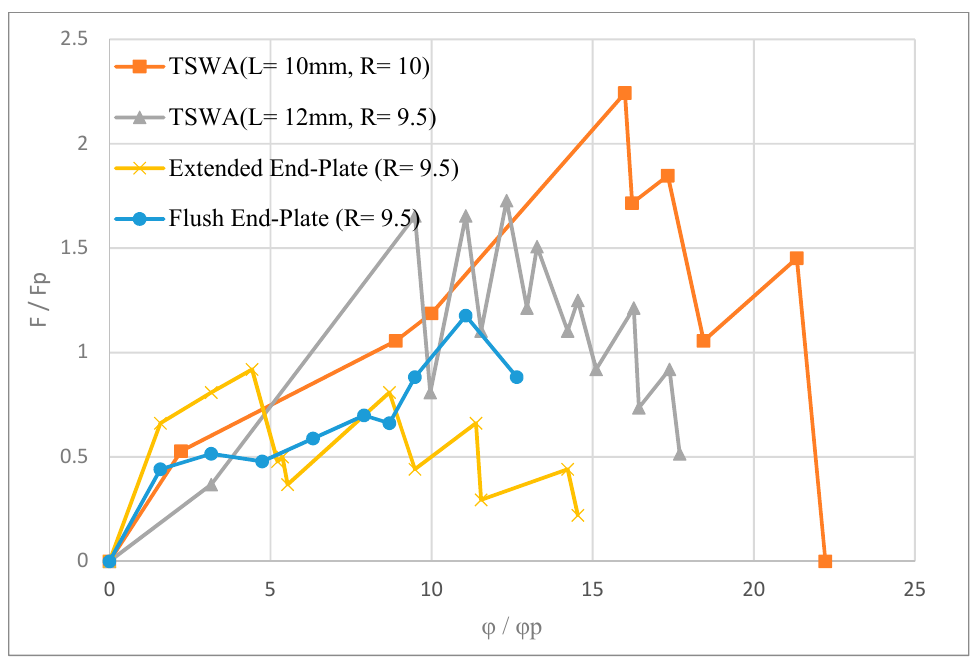
Figure 5. Normalized pushdown resistance against normalized rotation of semi-rigid connections. The normalized force versus normalized rotation for all tested fully rigid connections is shown in Figure 6. This category possesses the highest stiffness, where in the normalized rotation of around 2, almost all specimens develop the full plastic moment of connected beams. In addition, Figure 6 shows that by considering unique configuration and large R i , SidePlate has the highest stiffness and ultimate strength. Generally, the previous literature indicated that ductility demand for traditional rigid connections in the case of column removal is mainly controlled by the column shear panel zone, while in the SidePlate connection, it is controlled by a connected beam. Also, in fully rigid connections, the fracture at beam flange or shear plate are the main reasons for failure mode without premature weld or connection’s component failure.